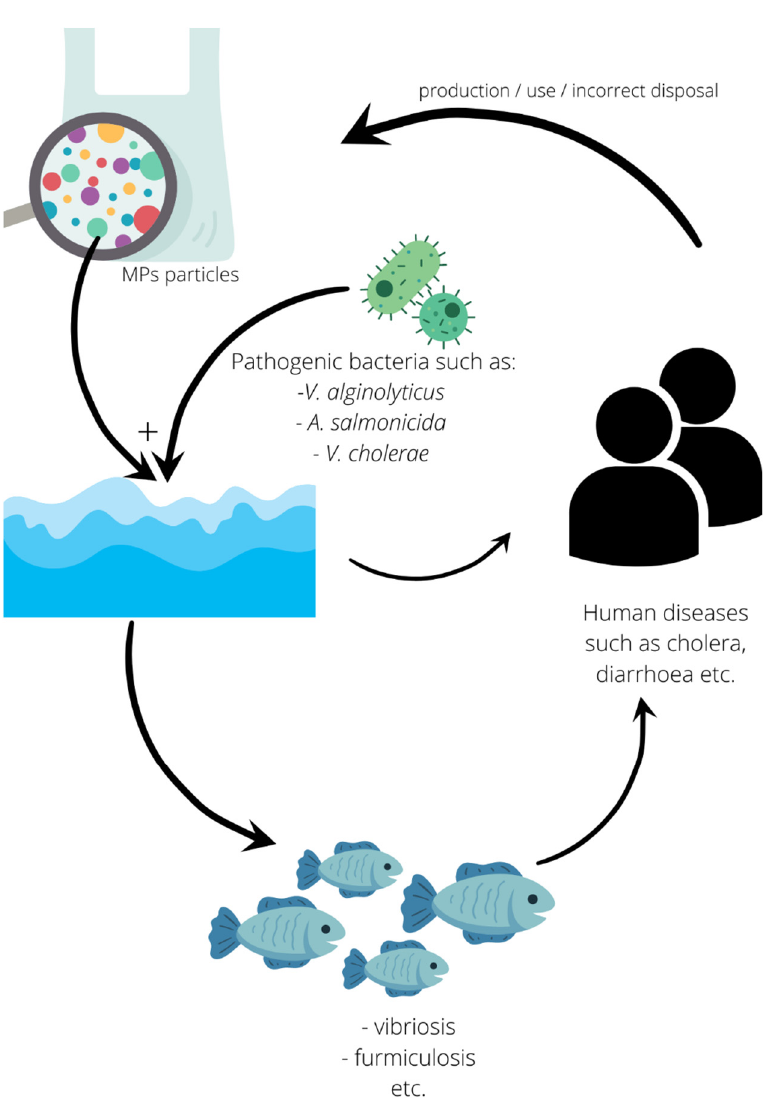
Figure 4. Microplastic as a vector of pathogens [19,86,95,96,121–125].